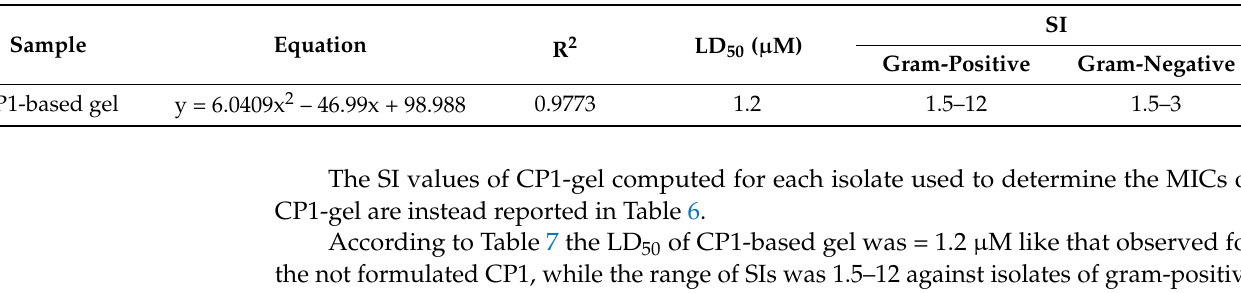
Table 7. Tendency line polynomial equation, R 2 value, LD 50 of CP1, as well as the relative SI ranges.